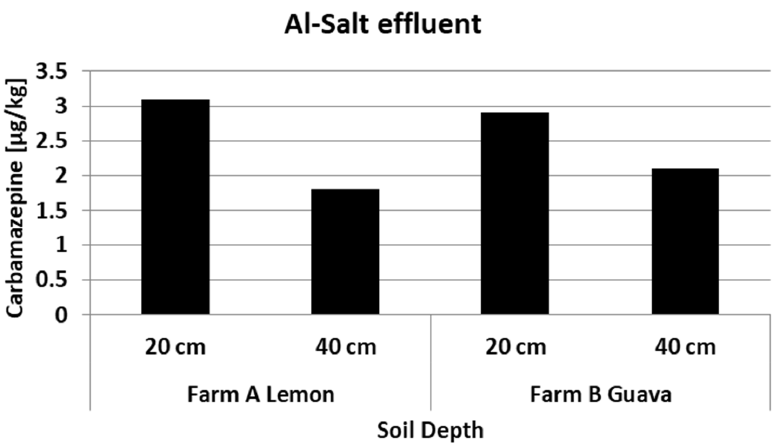
Figure 5. The concentration of carbamazepine in two different cultivated farms in Wadi Shueib.